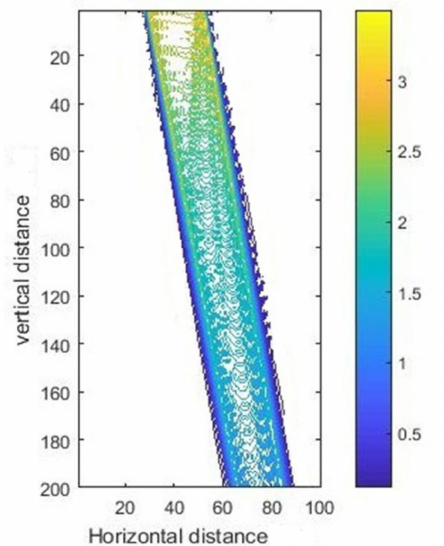
Figure 16. The contour map of intensity distribution for inclined exposure at incident angle 23.5 ◦